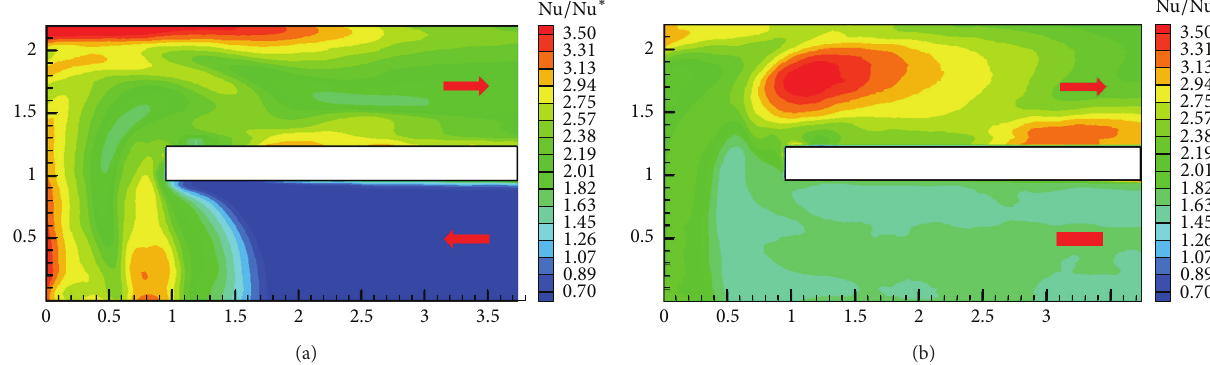
Figure 15: Normalised Nusselt number Nu / Nu ∗ distributions for a smooth rotating channel: (a) leading wall and (b) trailing wall; adapted from Gallo et al. [19].